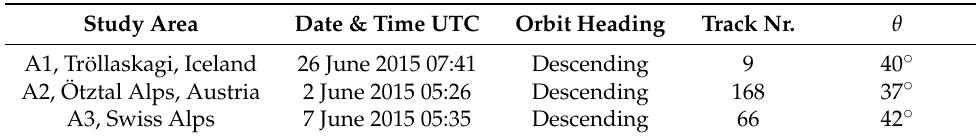
Table 3. Information on Sentinel-1 images used for comparison with Landsat snow maps. The incidence angle, θ , refers to a horizontal surface in the center of each